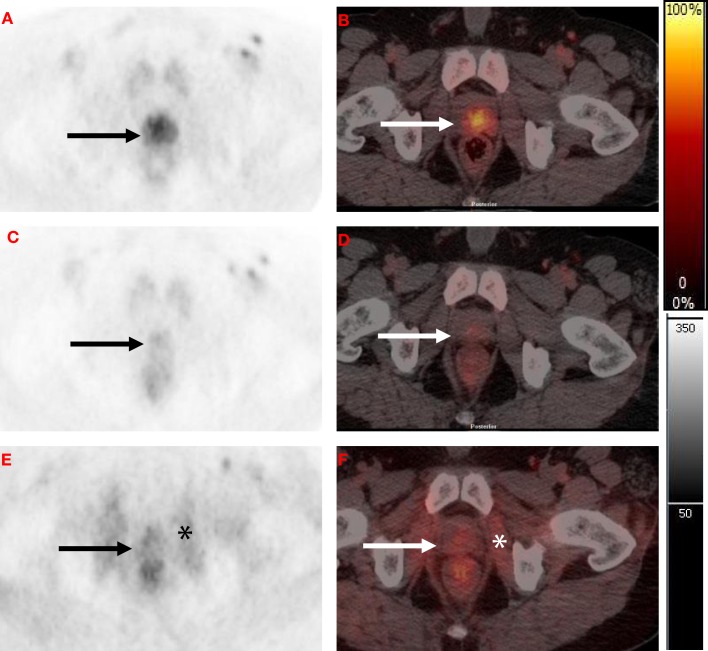
Axial [11C]choline PET and fused PET/CT at level of the prostate. (A,B) Baseline scan with focal activity in the peripheral zone (black and white arrows). (C,D) Post-neoadjuvant androgen deprivation therapy (NAD) scan (8–10 weeks after initiating NAD) with a marked reduction in [11C]choline uptake in the peripheral zone. (E,F) Post- radiotherapy combined with concurrent androgen deprivation therapy (RT-CAD) scan (4 months after completion of RT-CAD) with a further reduction in prostate activity and increased obturator internus muscular activity (black and white asterisk).